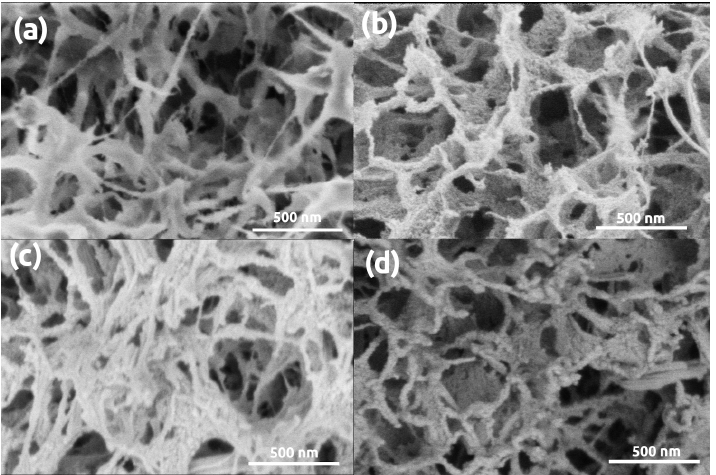
Figure 6. LVSEM images of polyamide aerogel samples. ( a ) Pristine, uncoated. ( b – d ) Sputter coated with 5 nm, 16 nm, 32 nm thick Au layers,